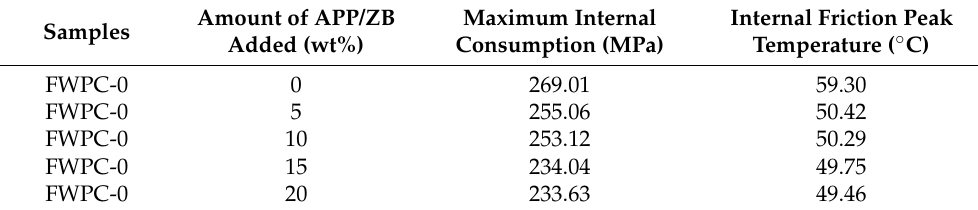
Figure 2. Effect of different APP/ZB content on the DMA of FWPC. Effect of different APP/ZB Figure 2. E ff ect of di ff erent APP/ZB content on the DMA of FWPC. E ff ect of di ff erent APP/ZB con- content on storage modulus ( a ) and loss modulus ( b ) under different temperature conditions. tent on storage modulus ( a ) and loss modulus ( b ) under di ff erent temperature conditions. Table 2. Effect of APP/ZB content on the characteristic value of FWPC loss Table 2. E ff ect of APP/ZB content on the characteristic value of FWPC loss modulus.